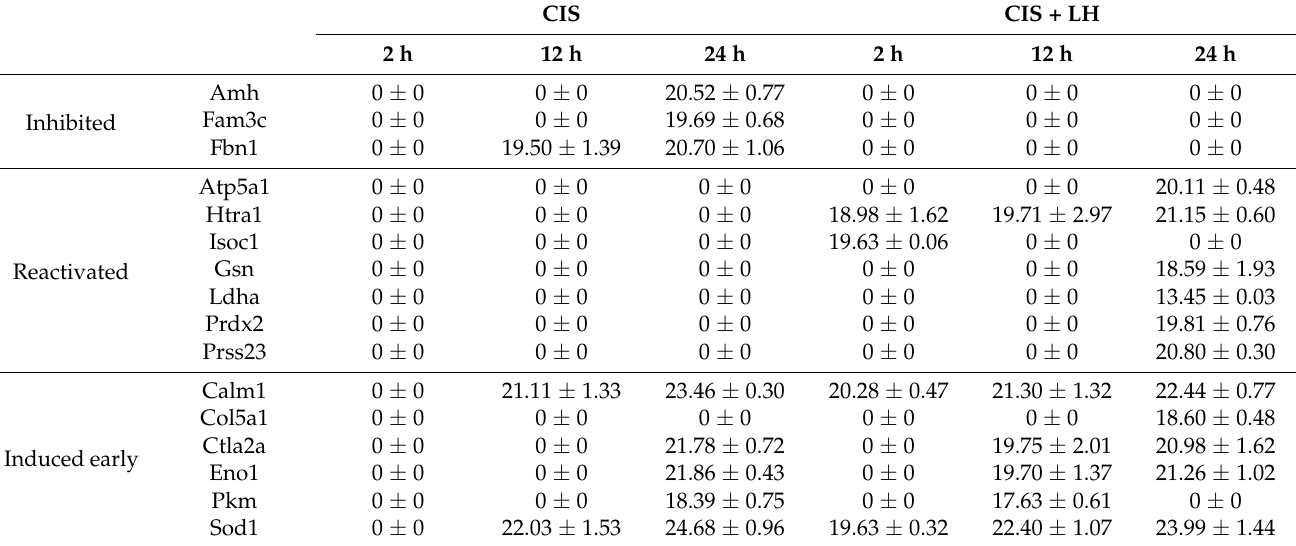
Table 2. Expression in CIS and CIS + LH of metabolites hypothetically implicated in the protective effect of LH against CIS-induced apoptosis. Mean log 2 iBAQ values and SD are reported. LH was able to inhibit the expression and/or the release in the microenvironment of probable proapoptotic factors induced by CIS in the ovarian tissues (Inhibited); reactivate those of several antiapoptotic factors inhibited by CIS (Reactivated); anticipate the induction of other (Induced early). CIS CIS +